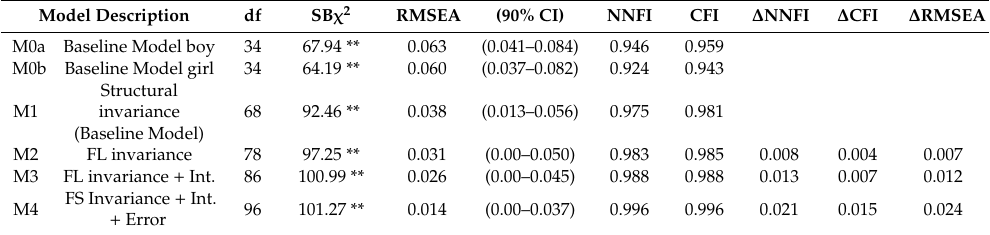
Table 3. Goodness-of-fit indexes of the invariance